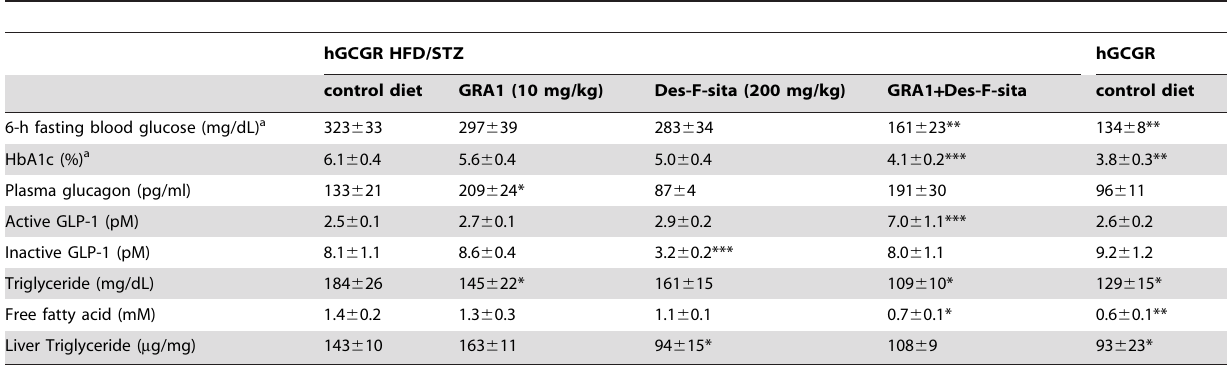
Table 4. Plasma and tissue measurements from hGCGR HFD/STZ mice treated for 6 weeks with 10 mg/kg GRA1, des-fluoro- sitagliptin (des-F-sita), or GRA1 and des-fluoro-sitagliptin in combination.